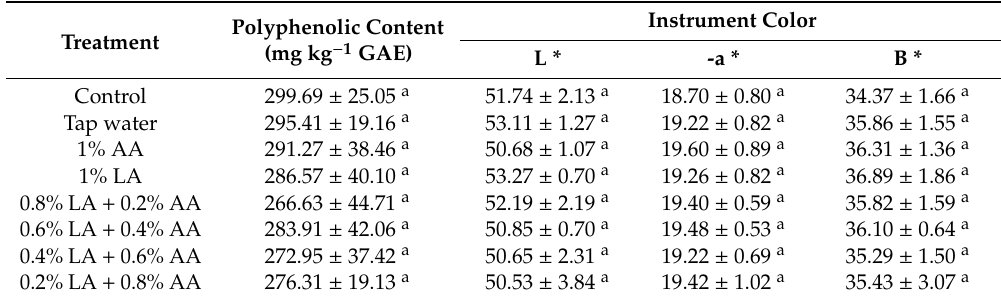
Table 1. Instrument color and total phenolic content of the disinfected sample stored for 5 days at 5 °C. Treatment